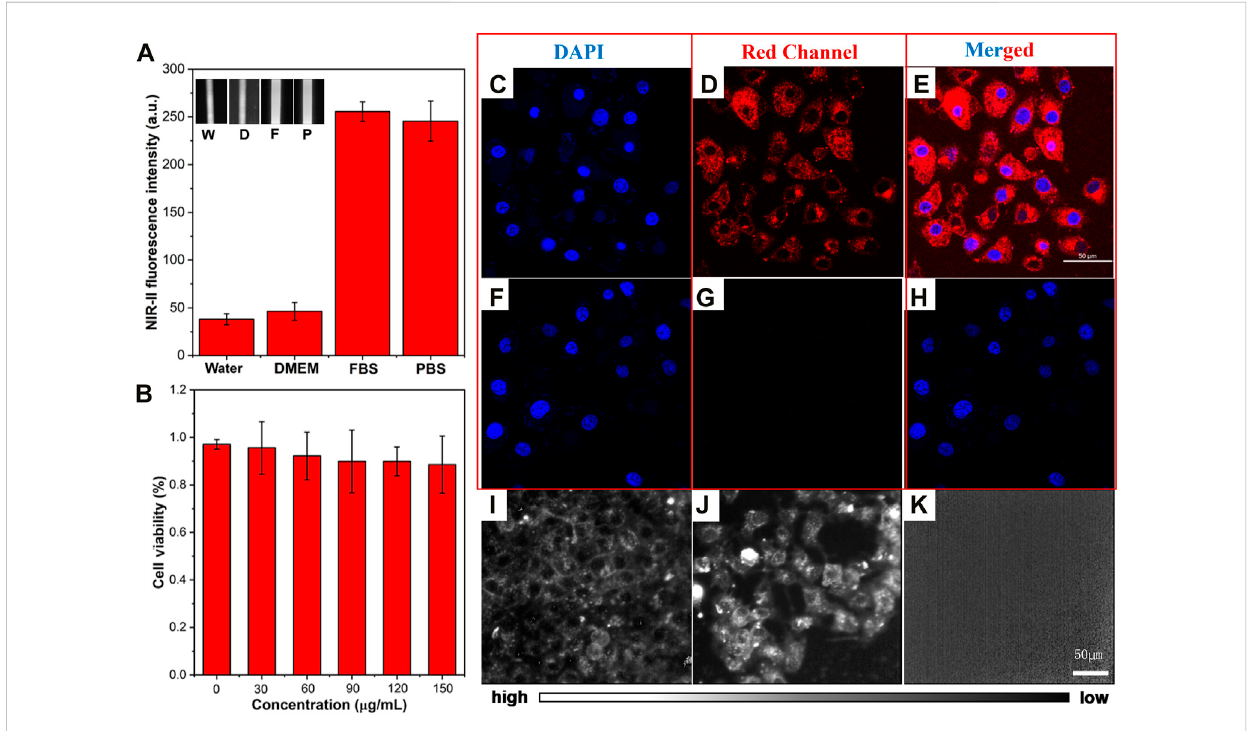
FIGURE 3 (A) NIR-II fl uorescence intensity of ICG in different solutions. Inset: NIR-II fl uorescence microscopic images of ICG in water (W), DMEM (D) , FBS (F) , and PBS (P) atthesame concentration of0.1 mg/mL ( λ excitation =808 nm). (B) Cell viability ofICG inL-02liver cells. (C – E) CLSM images of L-02 liver